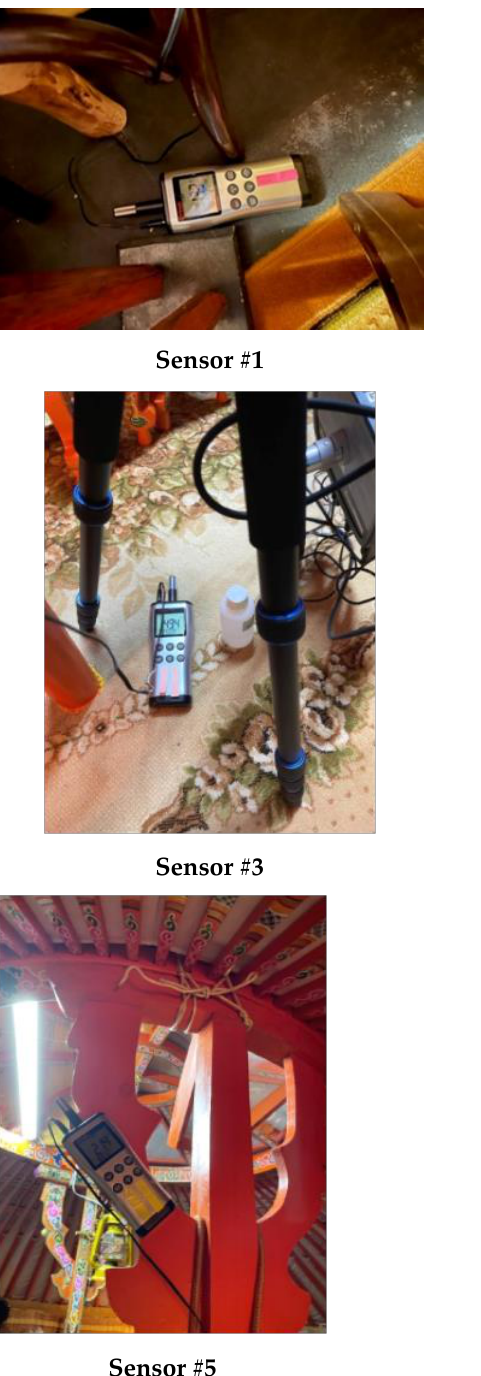
Figure 6. Location of Rotronic measuring devices in the yurt.